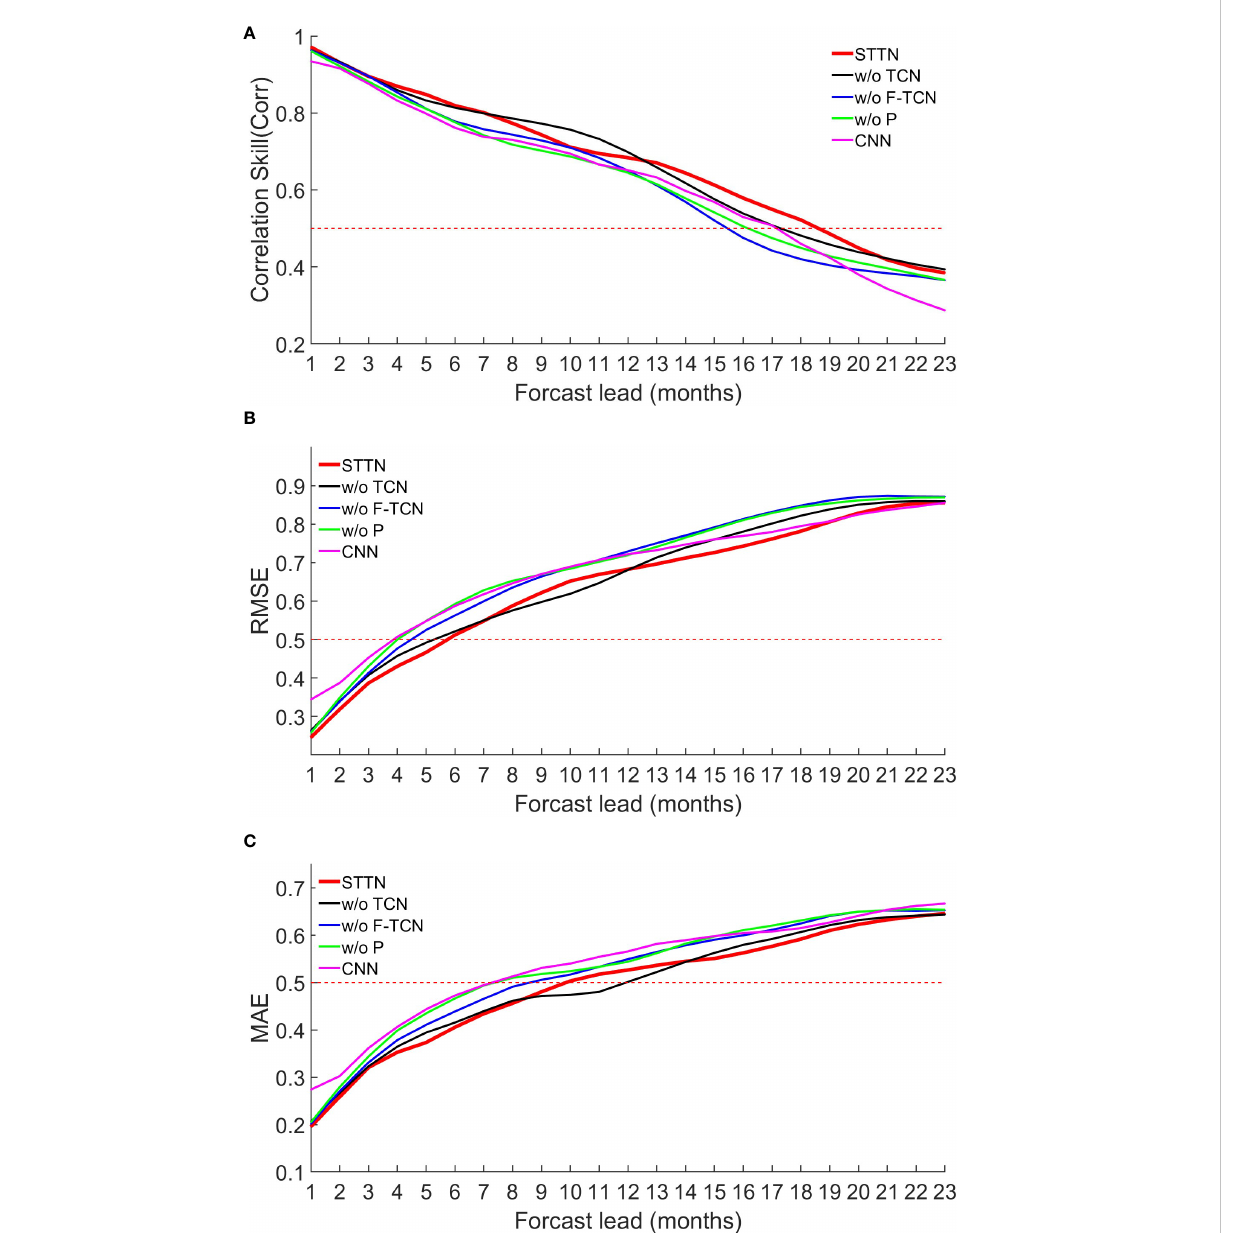
FIGURE 5 Comparison of (A) Corr, (B) RMSE, and (C) MAE between Niño3.4 index predictions and observations obtained with different modules. w/o X indicates removal of the X module. The purple line indicates the result of the CNN